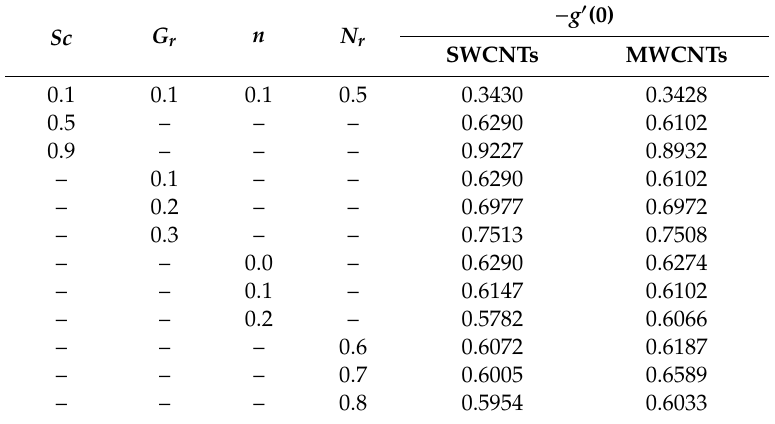
Table 5. Estimations of Sherwood number − g (cid:48) ( 0 ) versus di ff erent evaluations of various parameters.